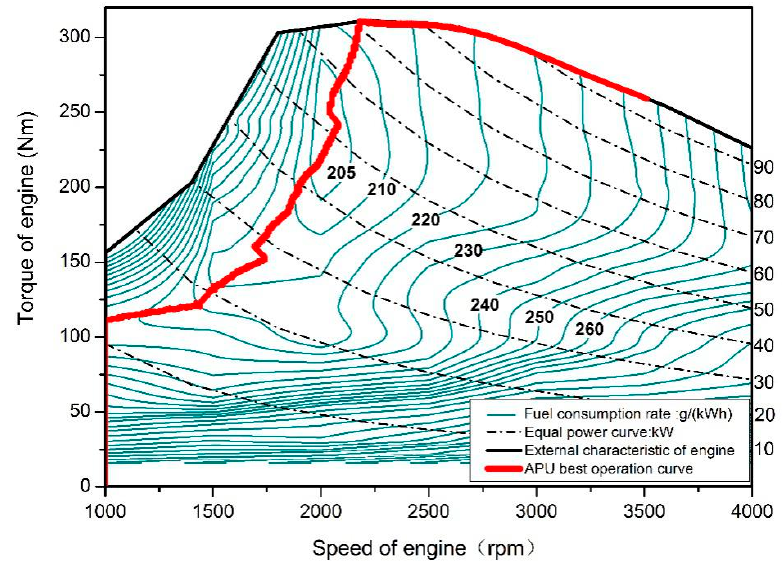
Figure 4. The APU best operation curve (red) and engine efficiency map.